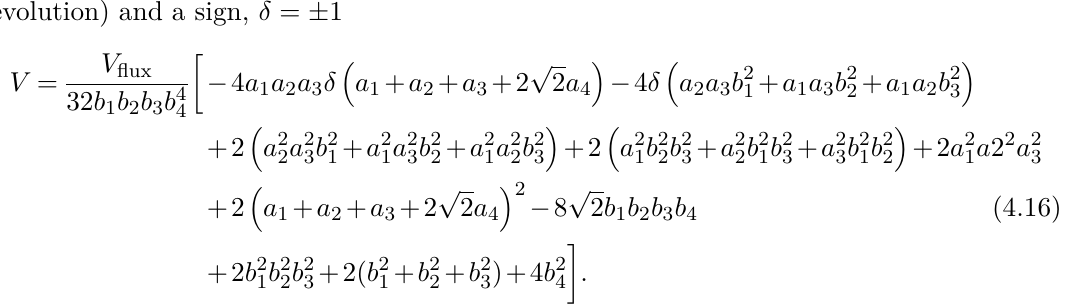
Table 3 . The Hessian’s eigenvector alignment and eigenvalues at the point φ a eigenvalue’s implied (cid:15) and ω/H , assuming that eigenvalue is the λ approximation (see (3.15)–(3.16)). Although these expressions are invalid when λ 9 H 2 , in this table we compute them anyway. The eigenvector and eigenvalue in the seventh row are the most aligned with the gradient direction, while the eigenvalue in the eighth row appears to support a rapid-turn solution. In the last row, we give the numerical method’s (cid:15) and ω/H evaluated at the same point. For reference, at this point (cid:15) The potential is known up to an overall constant V